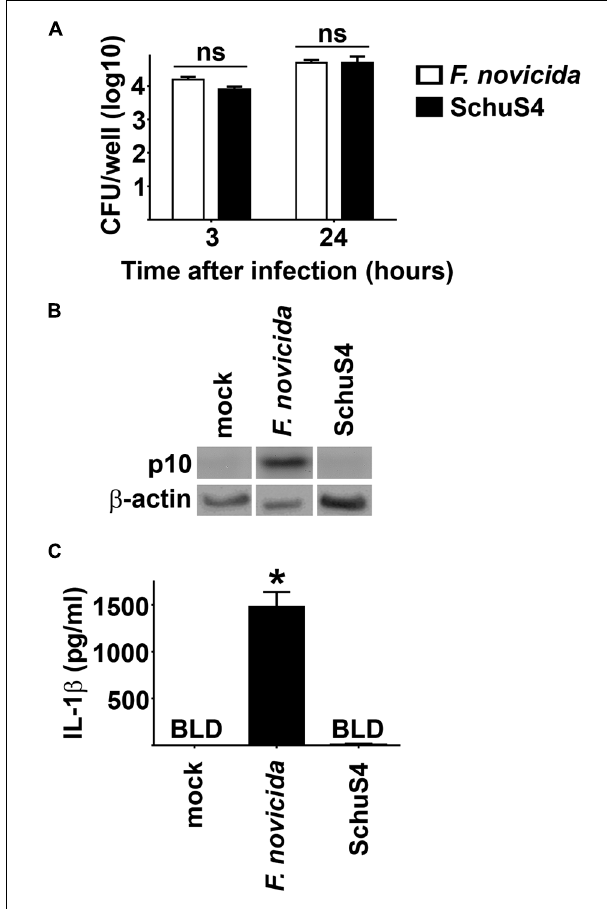
FIGURE 1 | Evasion of the inflammasome by virulent Francisella in bone marrow macrophages (BMM). BMM were infected with Fn MOI 250 and SchuS4 MOI 150. MOI were selected to match uptake of Fn and SchuS4. (A) Intracellular bacteria were enumerated at the indicated times after infection. (B) Western blots of cell lysates were probed for caspase-1 p10 and actin. (C) Culture supernatants were assessed for IL-1 β by ELISA. Error bars represent SD. ns, not significant, BLD, below level of detection, * p < 0.05 compared to all other groups. Data are representative of two independent